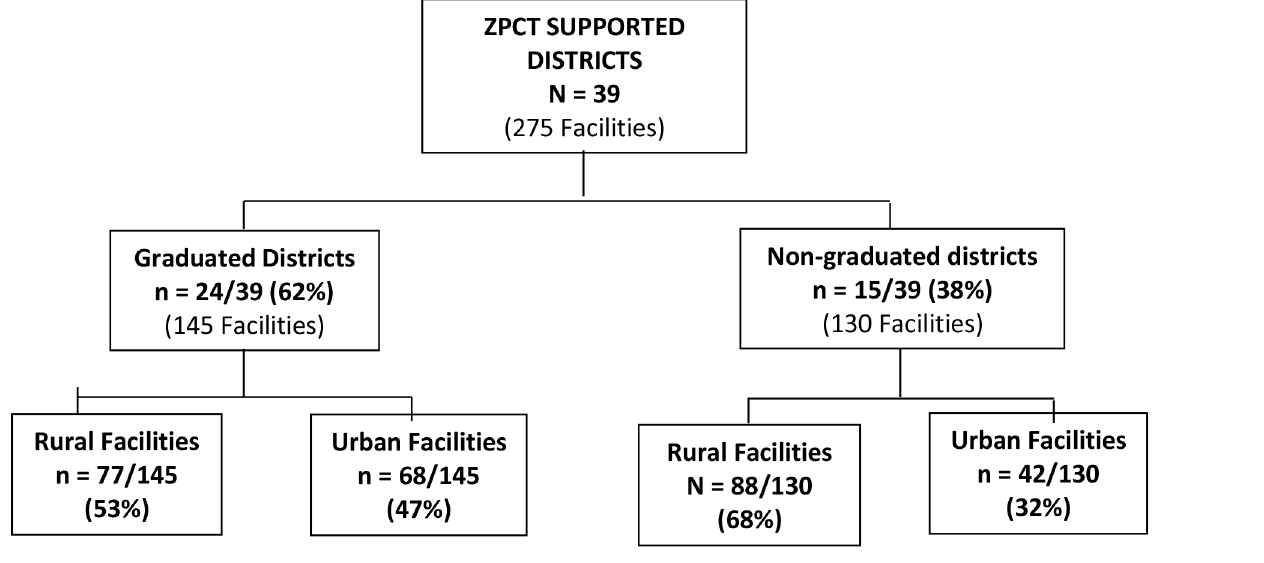
Fig 2. District Graduation